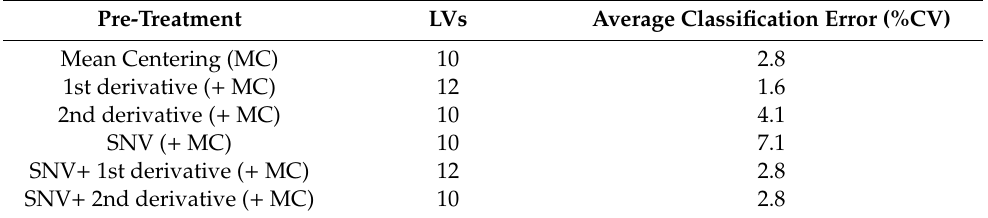
Table 3. PLS-DA modeling of the spectra collected on the kernel: results of cross-validation (LVs: Latent variables).